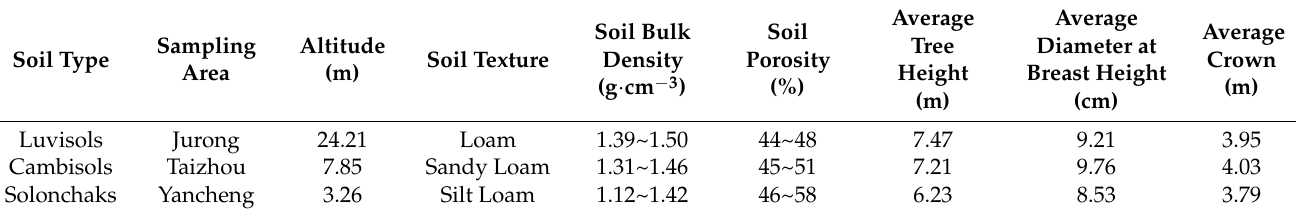
Table 1. Basic information of sampling sites in different soil types in Jiangsu Province, Eastern